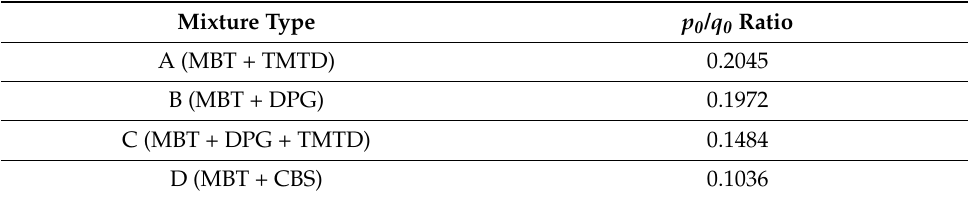
Figure 2. Charlesby–Pinner plots of the composites. Figure 2. Charlesby – Pinner plots of the composites. Table 4. p 0 / q 0 ratio of the Table 4. p 0 /q 0 ratio of the composites.